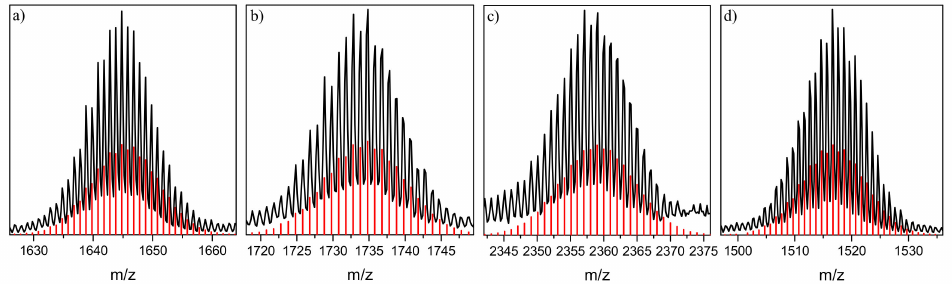
Figure 6. Selected areas of the ESI-MS spectra obtained by examination of a solution of ( a ) compound 3 in acetonitrile, ( b , c ) compound 4 in thf and ( d ) compound 5 in acetonitrile. ( a ) Negative ion mode (4500 V, 300 ◦ C) monitoring 3 with a cleaved [Ag-NHC] + moiety at m / z 1644.8 [NHC Dipp Ag {Ge 9 (Si(TMS) 3 ) 2 }] − . ( b ) Negative ion mode (4500 V, 300 ◦ C), monitoring 4 with a cleaved [Au-NHC] + moiety at m / z 1734.8 [NHC Dipp Au{Ge 9 (Si(TMS) 3 ) 2 }] − and ( c ) positive ion mode (6000 V, 300 ◦ C), monitoring 4 with an attached potassium cation at m/z 2359.0 [(NHC Dipp Au) 2 {Ge 9 (Si(TMS) 3 ) 2 }K] + . ( d ) Negative ion mode (4500 V, 300 ◦ C) monitoring 5 with a cleaved [Cu-NHC] + moiety at m/z 1516.6 [NHC Mes Cu{Ge 9 (Si(TMS) 3 ) 2 }] − . The simulated mass spectra with the corresponding